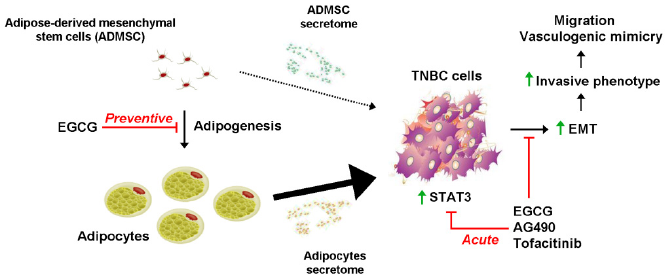
Figure 7. Scheme summarizing the preventive and acute effects of EGCG on STAT3-mediated ac- quisition of an invasive TNBC phenotype. Adipogenesis is induced during ADMSC differentiation into mature adipocytes. Both of the cell types have characteristic and distinct secretome profiles com- posed of different levels of pro-inflammatory cytokines, chemokines, and growth factors (Figure 1D). Whereas ADMSC secretome was characterized by some chemotactic properties towards TNBC cells (dotted arrow), this was significantly triggered by the secretome resulting from mature adipocytes (large arrow). EGCG was able to prevent such an effect by inhibiting adipogenesis (Preventive experimental condition). Increased EMT explains, in part, the resulting increases in TNBC cell migration and vasculogenic mimicry in response to the adipocytes secretome, the response of which can be reduced through the inhibition of STAT3-mediated signaling by EGCG, AG490, and Tofacitinib (Acute experimental condition).